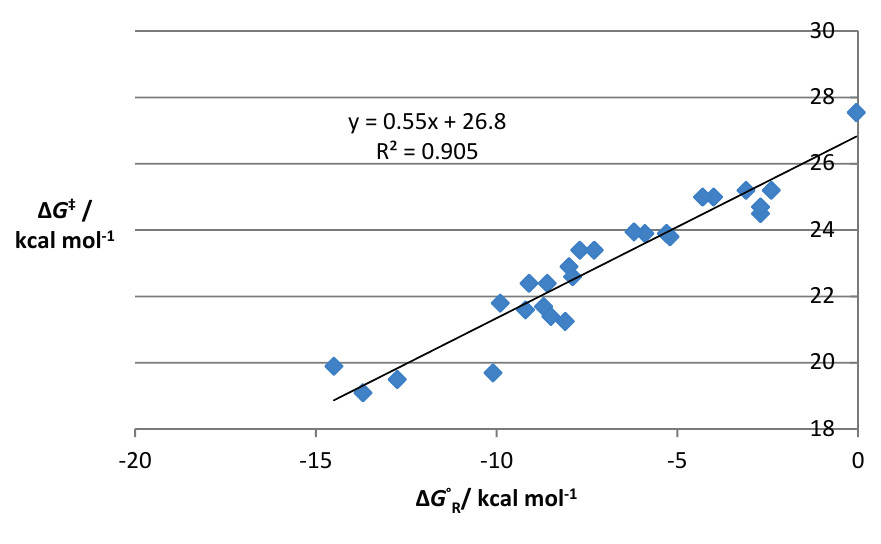
Figure 1. Leffler plot of ∆ G ‡ vs. ∆ G ° R (at 383 K) for our original 26 IMDAF substrates, 1 – 26